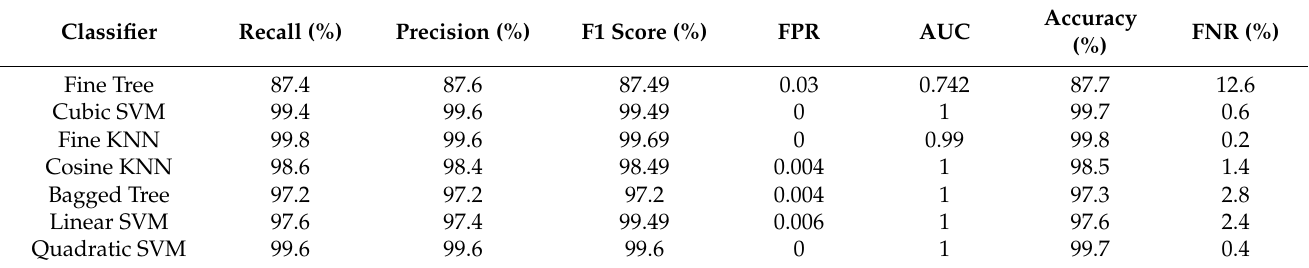
Table 6. Classification results using the GA for VGG19 model